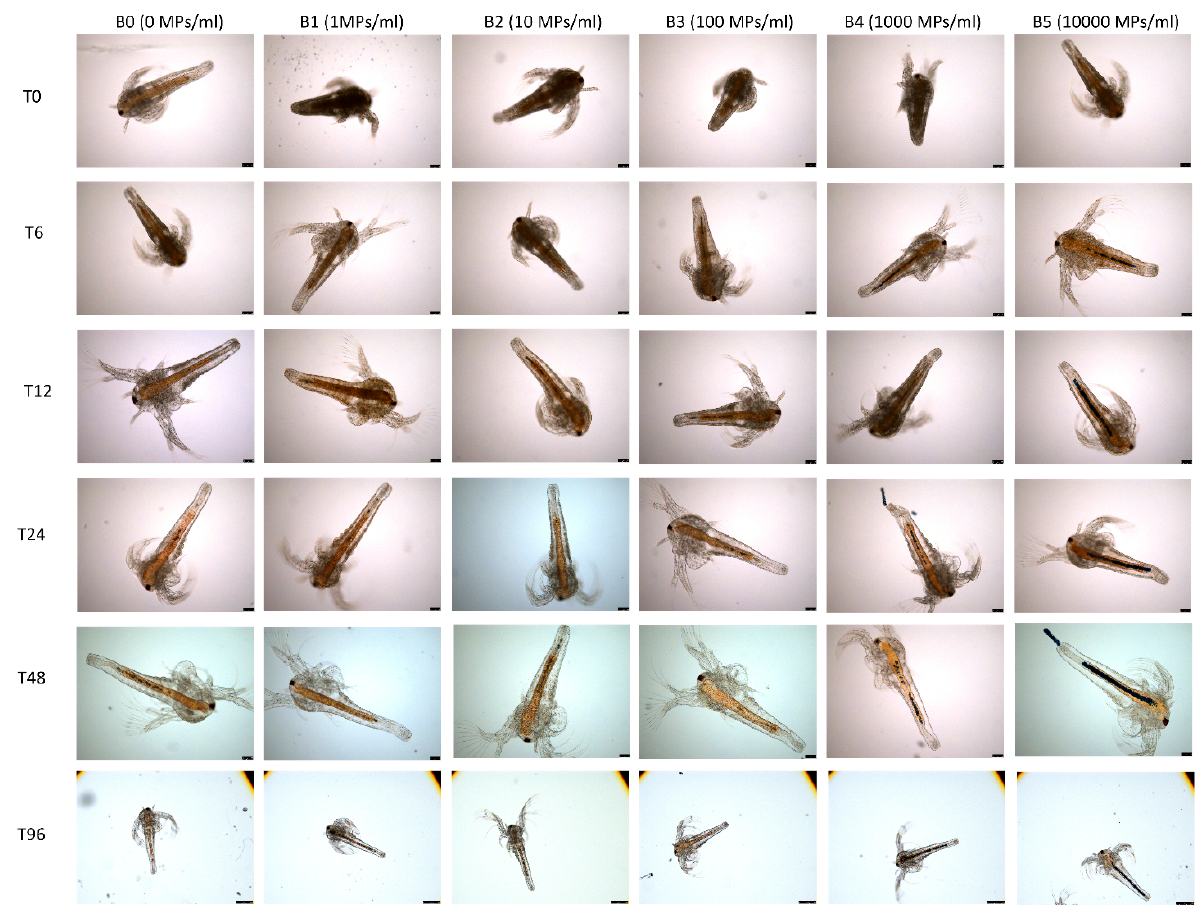
Figure 6. Development of Group B Artemia salina nauplii six treatments (B0–B5) in time (0–96 h). Scale bars: 75 µm for time points T0–T48; 250 µm for time point T96.